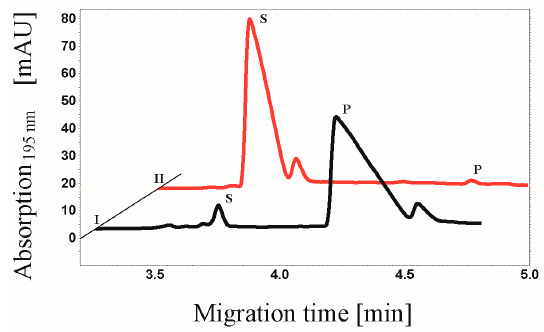
Figure 1. Comparison of the phosphorylation activity of the heterotetrameric CK2 before and after reaction with FITC. The CE-based assay as described before by Gratz et al. [23] was used to determine the CK2 activity. Electropherogram of the phosphorylation of the substrate peptide RRRDDDSDDD (114 µM) by unlabeled (I, 2.6 µg) and fluorescein-conjugated CK2 (II, 2.6 µg) after an incubation time of 30 min is shown. Substrate (S) and product (P) peaks were detected after 3.7 min and 4.3 min, respectively.